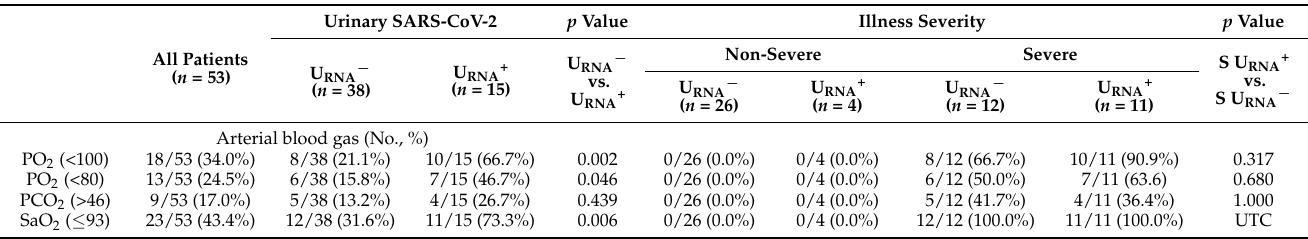
Table 2. Arterial blood gas analysis of 53 enrolled